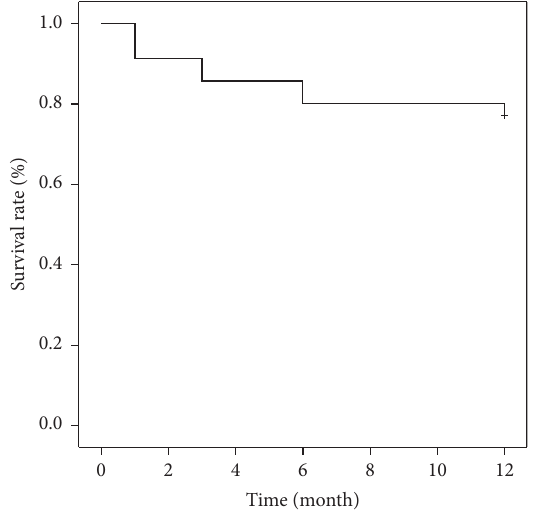
Figure 3: Kaplan–Meier survival curve for success after cyclo- photocoagulation under microscopic direct vision combined with the phacoemulsification for primary angle-closure glaucoma. Success was defined as 8 ≤ postoperative intraocular pressure ≤ 20mmHg without